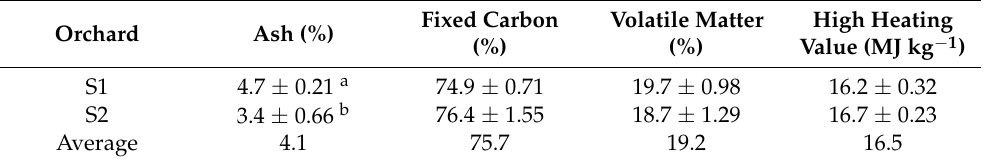
Table 3. Chemical and energetic properties of the biomass obtained in thinning pruning at two walnut orchards established in Durango, M é xico. Orchard Ash